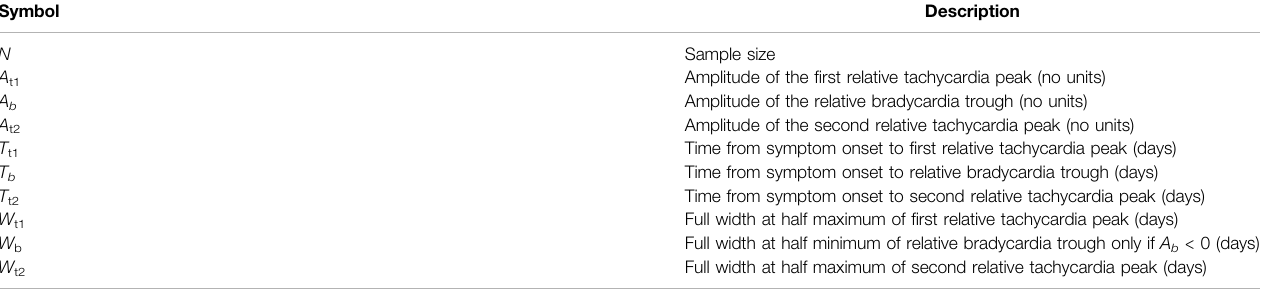
TABLE 2 | Description of parameters. Symbol